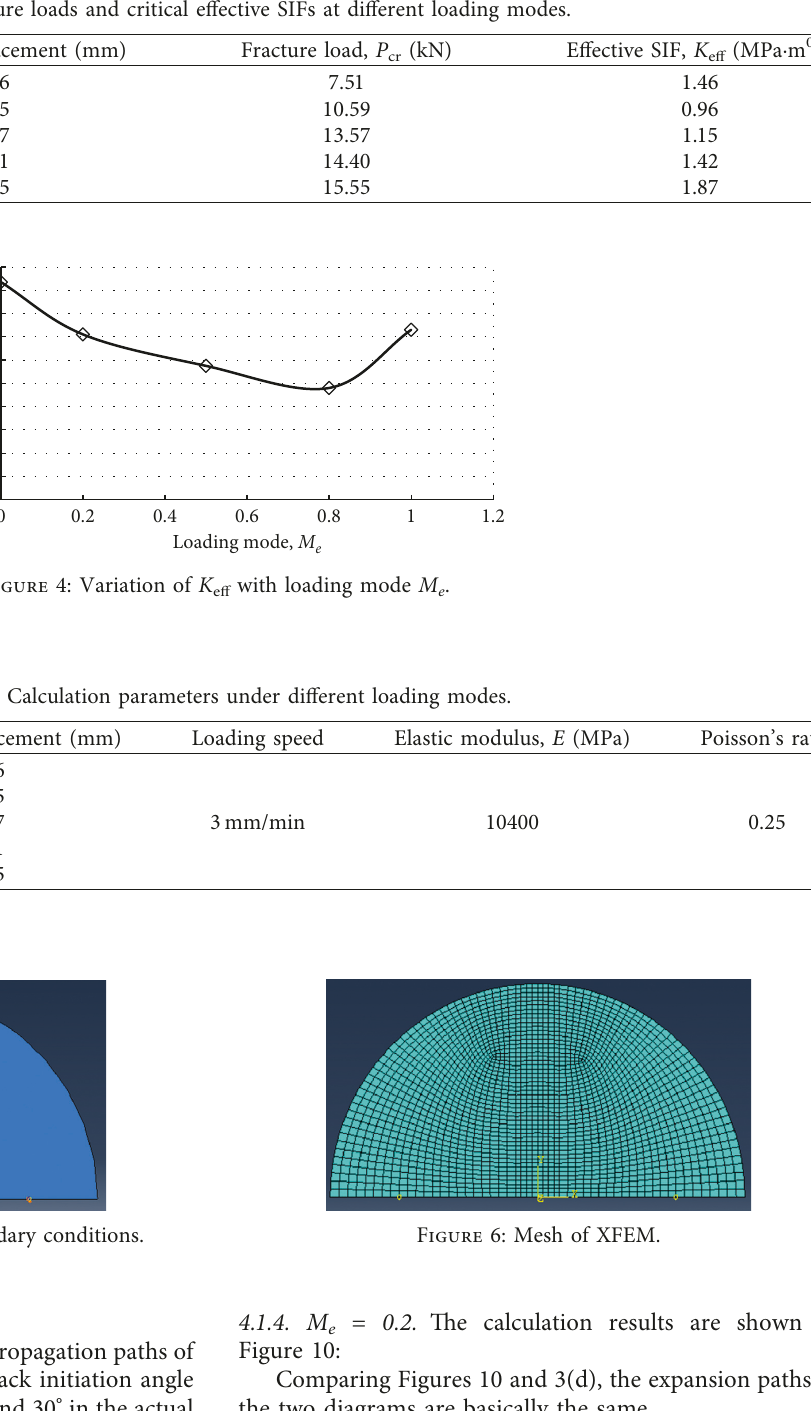
Comparing Figures 9 and 3(c), the expansion paths of the two are basically the same.